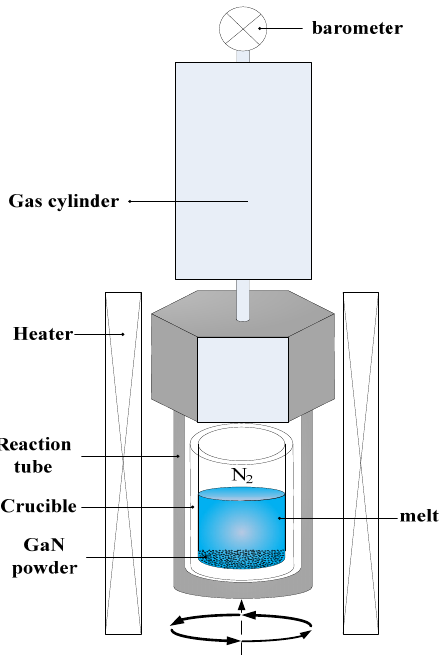
Figure 1. Schematic diagram of GaN crystal growth in Na alloy melt.